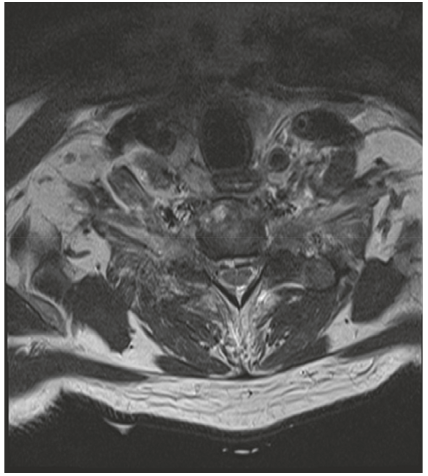
Figure 4: MRI thoracic spine showing local invasion of